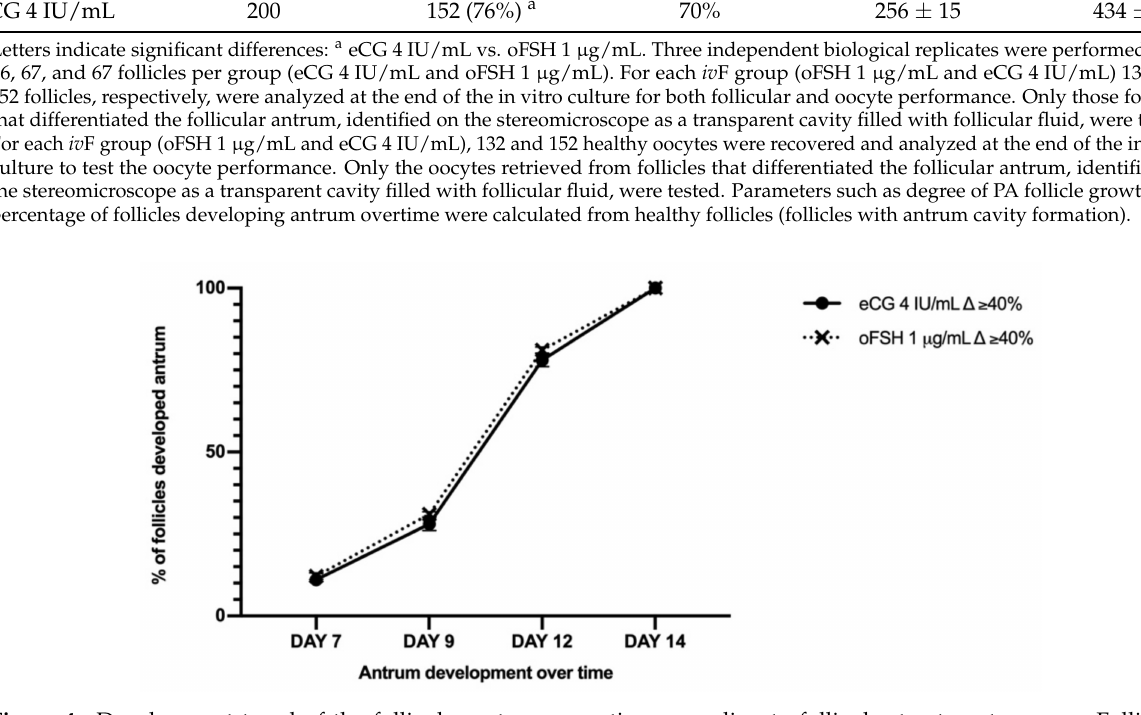
Figure 4. Development trend of the follicular antrum over time according to follicular treatment groups. Follicular development and antrum differentiation: Three independent biological replicates were performed. For each biological replicate, 66, 67, and 67 follicles per group (eCG 4 IU/mL and oFSH 1 µ g/mL) were